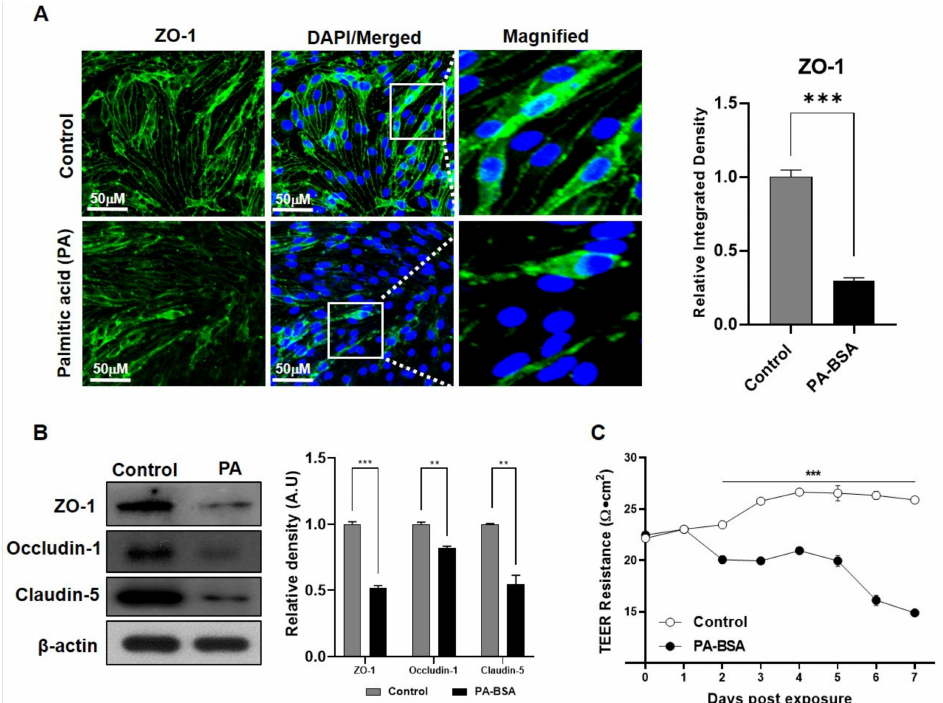
Figure 4. PA-BSA affects the expression of tight junction proteins. ( A ) Confocal microscope im- ages show the co-expression of ZO-1 in bEnd.3 cells in the control and the bovine serum albumin- conjugated palmitic acid (PA-BSA)-treated group. ( B ) Immunoblot analysis was used to compare the expression levels of tight junction proteins ZO-1, occludin-1, and claudin-5 expressed in bEnd.3 cells from the control and PA-BSA-treated group. ( C ) TEER resistance values were measured across the co-cultured transwell membrane of the control group and PA-BSA-treated group. All data had a sample size of three ( n = 3) and three experimental repeats. Data are presented as mean ± SEM. p < 0.05 was considered to be statistically significant. ** p ≤ 0.01 and *** p ≤